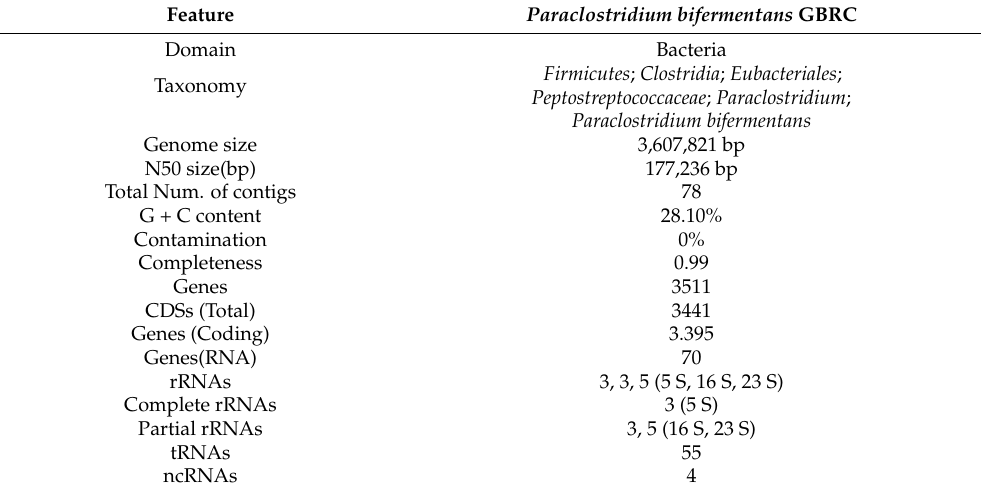
Table 2. General feature of P. bifermentans GBRC draft genome.